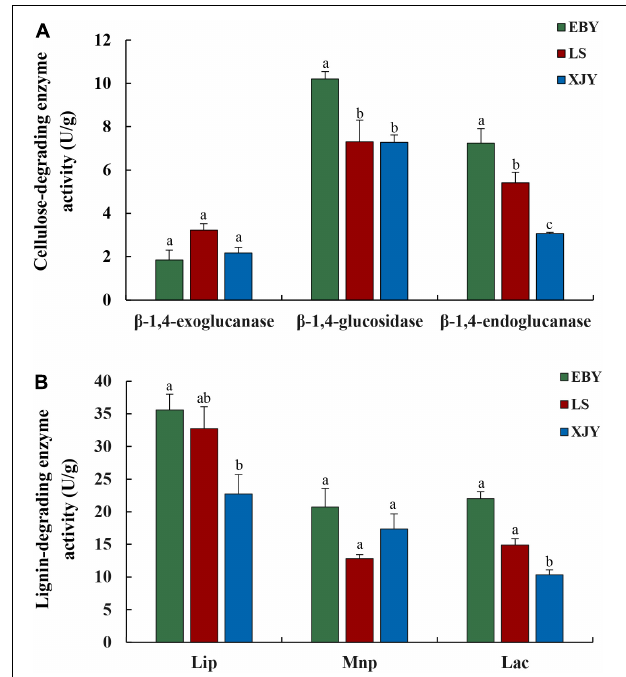
FIGURE 2 | Gut enzyme activity of A. glabripennis larvae fed on different Populus gansuensis (EBY), Salix babylonica (LS), or Populus alba var. pyramidalis (XJY) as host tree species. (A) Cellulose-degrading enzyme activity in the larval gut. (B) Lignin-degrading enzyme activity in the larval gut. LiP, lignin peroxidase; MnP, manganese peroxidase; Lac, laccase. Results followed by different letters are significantly different according to the HSD test ( p ≤